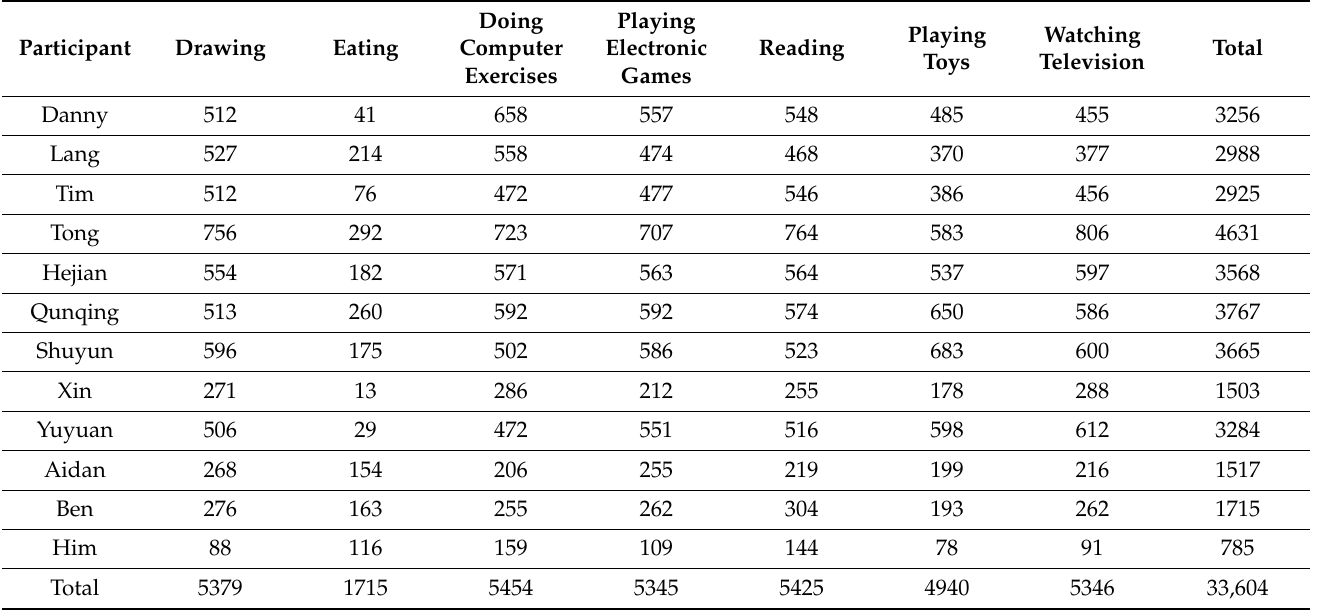
Table 1. The total numbers of the retained samples when different participants are conducting different activities under the concentration state.